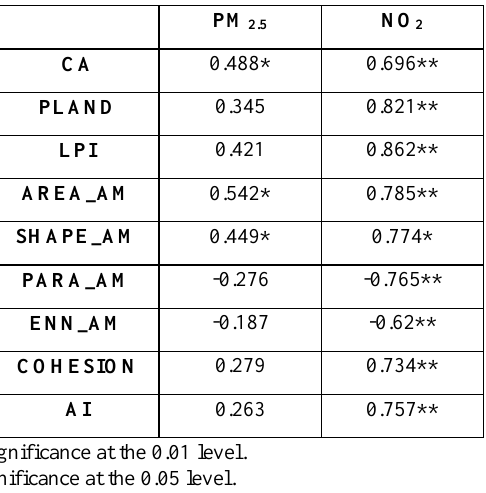
Table 1. The Pearson coefficient (r) between urban form metrics and air